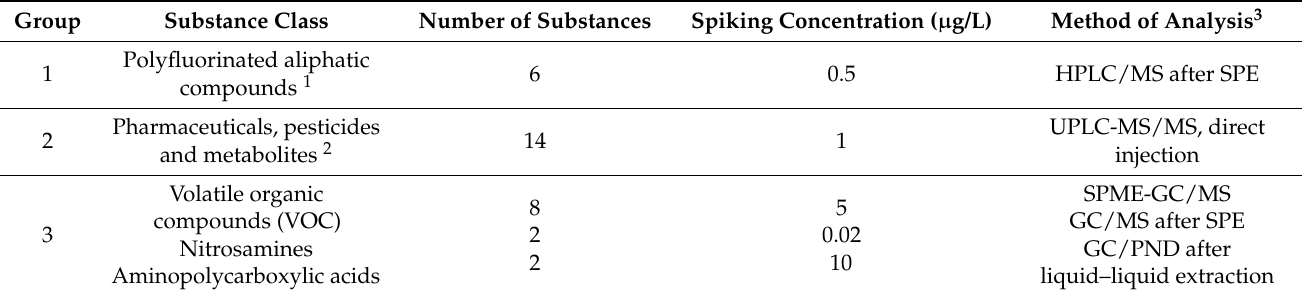
Table 4. Classification of TrOCs, spiking concentrations and analysis